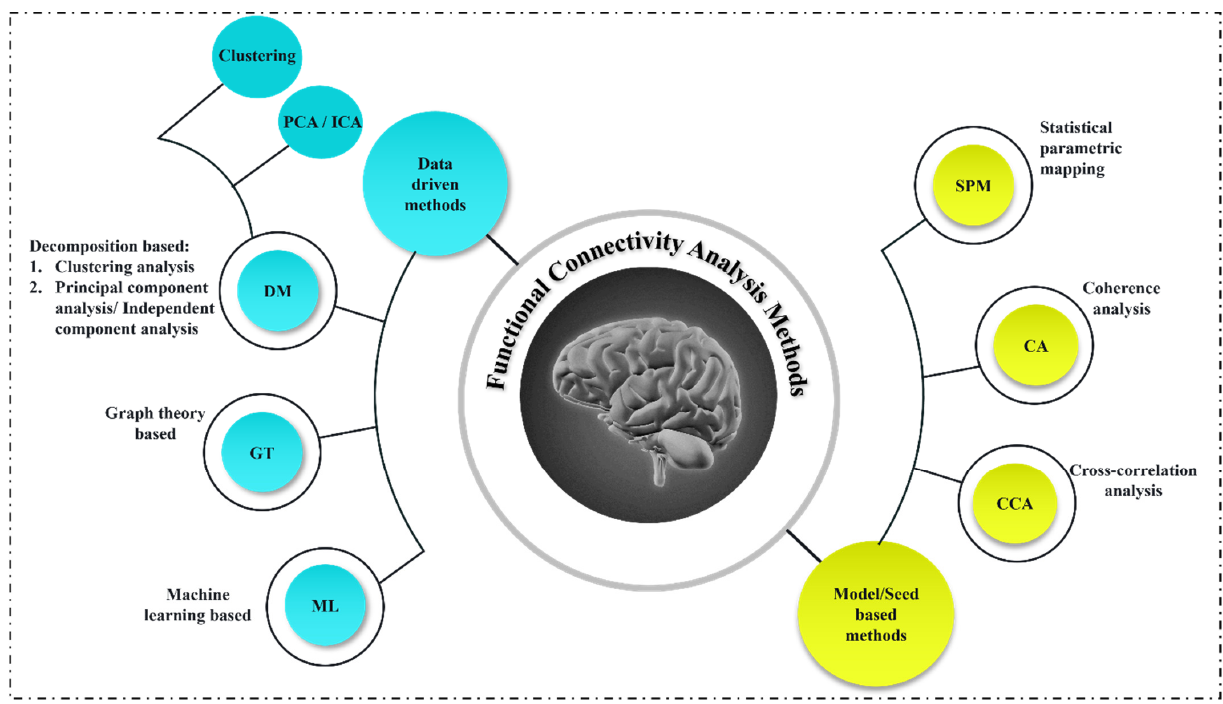
Figure 1. Functional connectivity analysis methods.